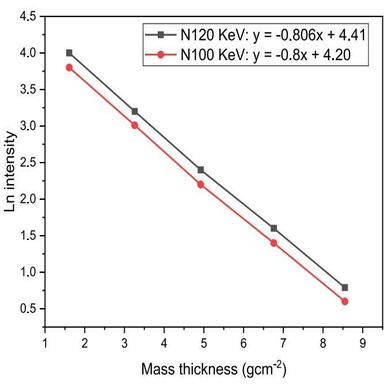
Transmitted intensity across lead sheet thickness for N100 KeV and N120 KeV.